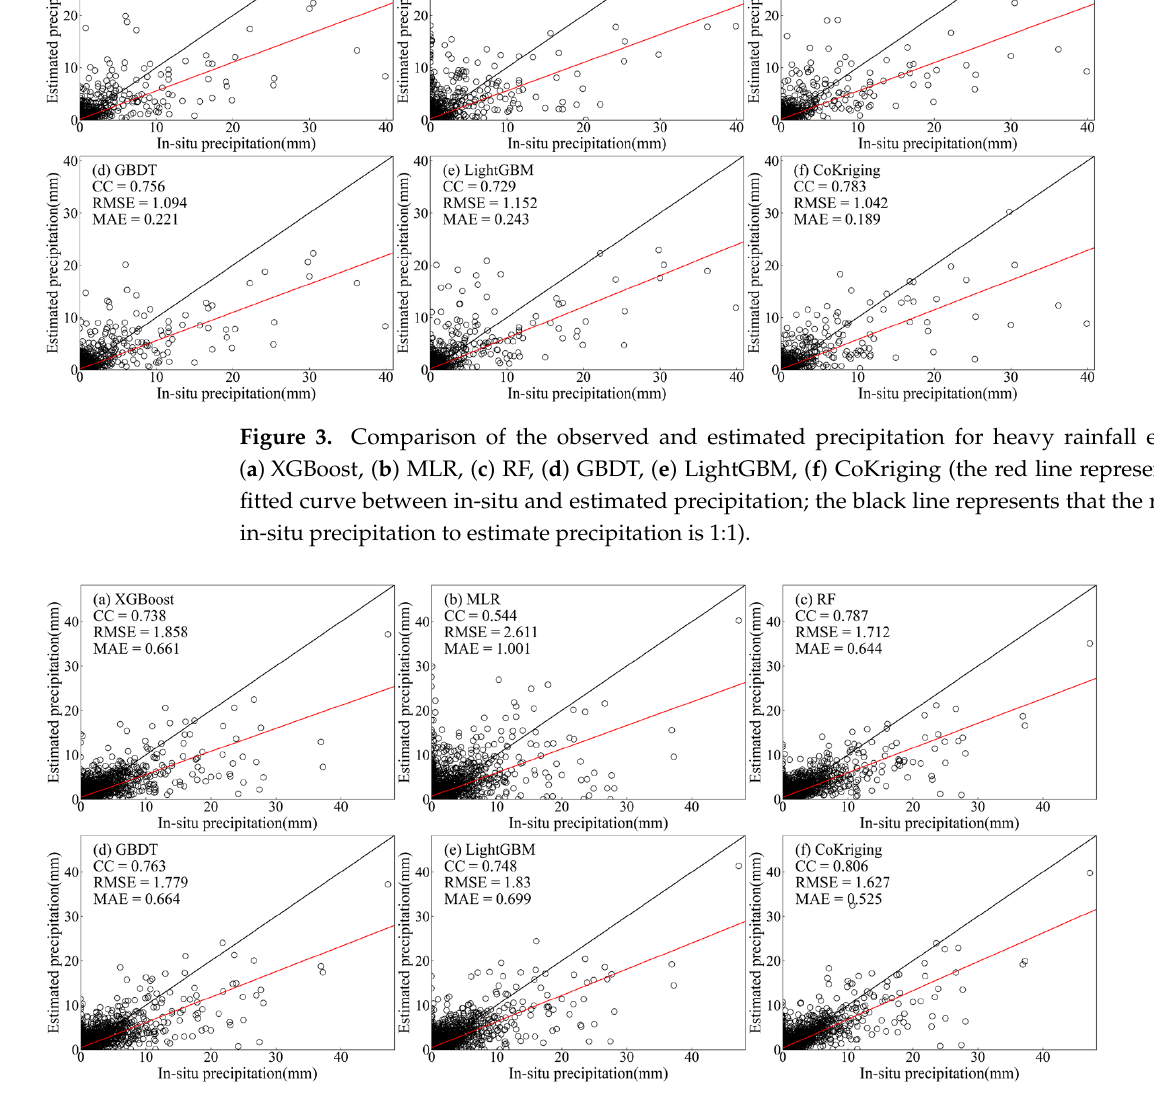
Figure 4. Comparison of the observed and estimated precipitation for heavy rainfall event II : (a) XGBoost, (b) MLR, (c) RF, (d) GBDT, (e) LightGBM, (f) CoKriging (the red line represents the fitted curve between in-situ and estimated precipitation; the black line represents that the ratio of in-situ precipitation to estimate precipitation is 1:1).